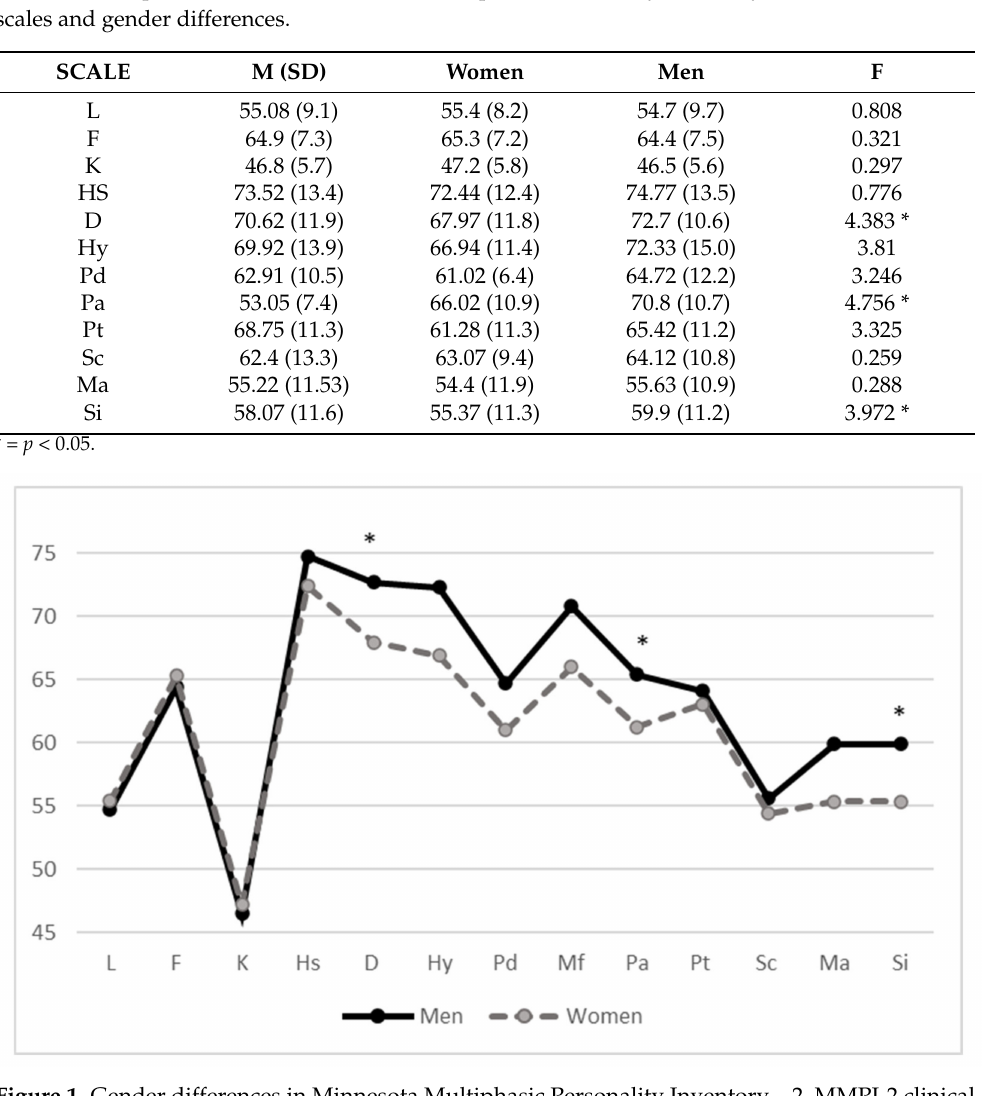
Figure 1. Gender differences in Minnesota Multiphasic Personality Inventory—2, MMPI-2 clinical scales (Mean T score). * significant differences of at least p <